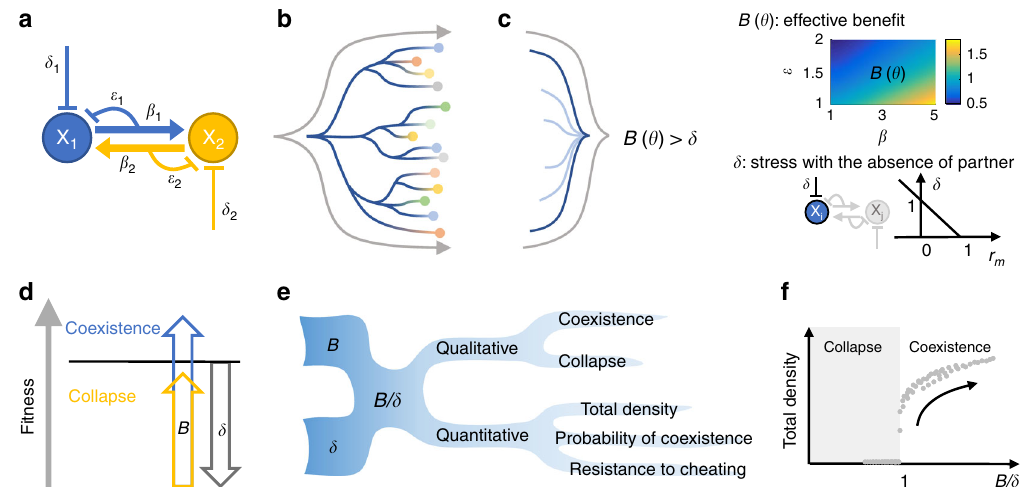
Fig. 1 B and δ are two driving forces that determine qualitative and quantitative mutualistic outcomes. a The basic logic of mutualistic systems. The two partner populations are denoted by X 1 and X 2 . β 1 and β 2 describe the level of bene fi t. ε 1 and ε 2 describe the cooperation cost of providing bene fi t. The two populations also experience stress δ 1 and δ 2 . b Models originating from the basic logic of mutualism yield diverse coexistence criteria. Each line represents the generation of a model from the basic mutualism logic and branching represents different implementation details and system complexities. The circles represent the models and diverse coexistence criteria derived from these models. This process aims to re fl ect the diversity of mutualistic systems in nature. c A simple rule emerges at an appropriate level of abstraction. The lines represent the abstraction process that establishes B ( θ ) > δ as the common structure shared by diverse models in panel b. B ( θ ) represents effective bene fi t and is a complex function of model parameters θ , which include β and ε . B increases with increasing β and decreasing ε . The heatmap is generated using Eq. (4). δ is the stress experienced by one population. r m is growth rate measurement. Note that the color bar is dimensionless, and it is the same for all following color bars. d Intuitive interpretation of the simple rule. The effective bene fi t B must overcome stress δ for the system to coexist. Solid black line represents coexistence boundary and dashed black line represents baseline fi tness level with the absence of partner. Blue represents a B that is greater than δ (coexistence) and yellow represents a B that is smaller than δ (collapse). e B / δ can predict various system outcomes. If the two features B and δ are known, many downstream predictions, both qualitative and quantitative, can be made. f Quantitative outcomes versus B / δ . Simulation results show when B / δ > 1, it is predictive of total density. Note that the points do not necessarily lie on a single curve, but a positive trend is well-maintained. Other quantitative outcomes also follow similar positive trends when